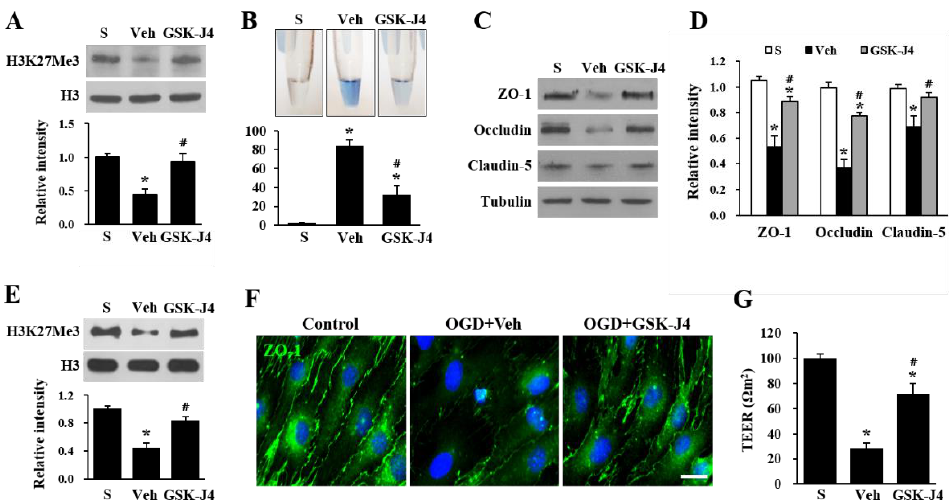
Figure 3. Jmjd3 regulates blood-nerve barrier permeability after cauda equine compression. At 30 d after the compression injury, GSK-J4 (20 µg) or vehicle (Veh) was intrathecally injected, and the cauda equina was prepared 30 min after drug injection. ( A ) Western blot and quantitative analysis for H3K27Me3. The data are presented as the mean ± SD (n = 3). ( B ) Representative cauda equina homogenates in e-tube (upper panel) and quantification (bottom panel) of the amount of Evans blue dye extravasation 30 d after compression. Data represent as mean ± SEM (n = 5). * p < 0.05 vs. Sham; # p < 0.05 vs. Vehicle. ( C ) Western blots for ZO-1, occludin, and claudin-5 in the cauda equina. ( D ) Quantitative analysis of Western blots. The data are presented as the mean ± SD (n = 3). * p < 0.05 vs. Sham; # p < 0.05 vs. Vehicle. ( E – G ) bEnd.3 cells were pretreated with vehicle or GSK-J4 (4 µ M) for 30 min before oxygen-glucose deprivation (OGD) for 6 h. ( E ) Western blot and quantitative analysis for H3K27Me3 at 1 h reoxygenation after OGD. The data are presented as the mean ± SD (n = 3). * p < 0.05 vs. Sham; # p < 0.05 vs. Vehicle. ( F ) Immunocytochemistry for ZO-1 from fixed bEnd.3 cells at 6 h reoxygenation after OGD. S cale bar, 30 μm. ( G ) After being treated with control or GSK-J4, bEnd.3 cells were subjected to OGD/reperfusion injury, and TEER was measured at reperfusion 1 h after OGD, as described in the Methods section. The data are presented as the mean ± SD (n = 3). * p < 0.05 vs. Sham; # p < 0.05 vs. Vehicle.